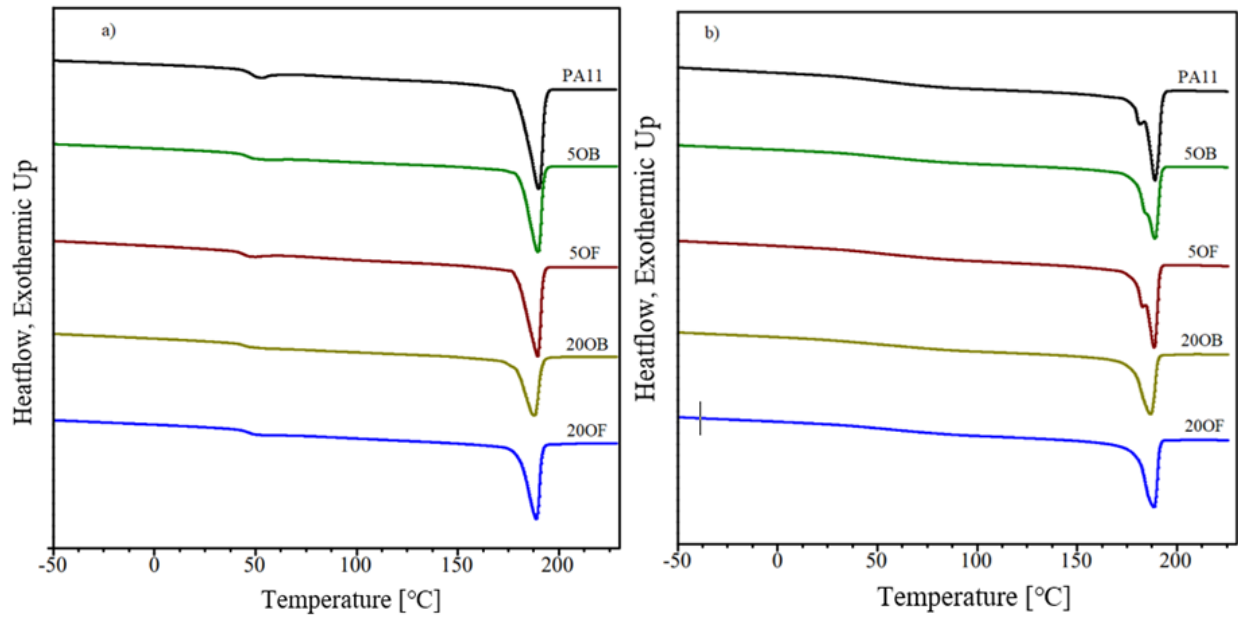
Figure 17. DSC curves of unmodified PA11 and biocomposites based on PA11 with different weight fractions of diatoms obtained during first heating procedure ( a ) and second heating procedure ( b ), respectively. Table 8. Thermal characteristics of PA11 and biocomposites based on PA11 with different weight fractions of diatoms.